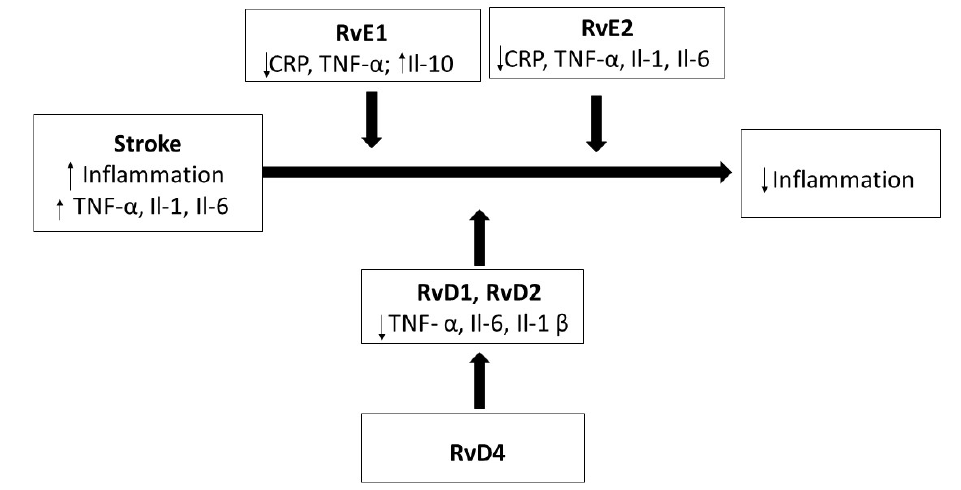
Figure 3. The e ff ect of resolvins on inflammation after a Figure 3. The effect of resolvins on inflammation after a stroke.